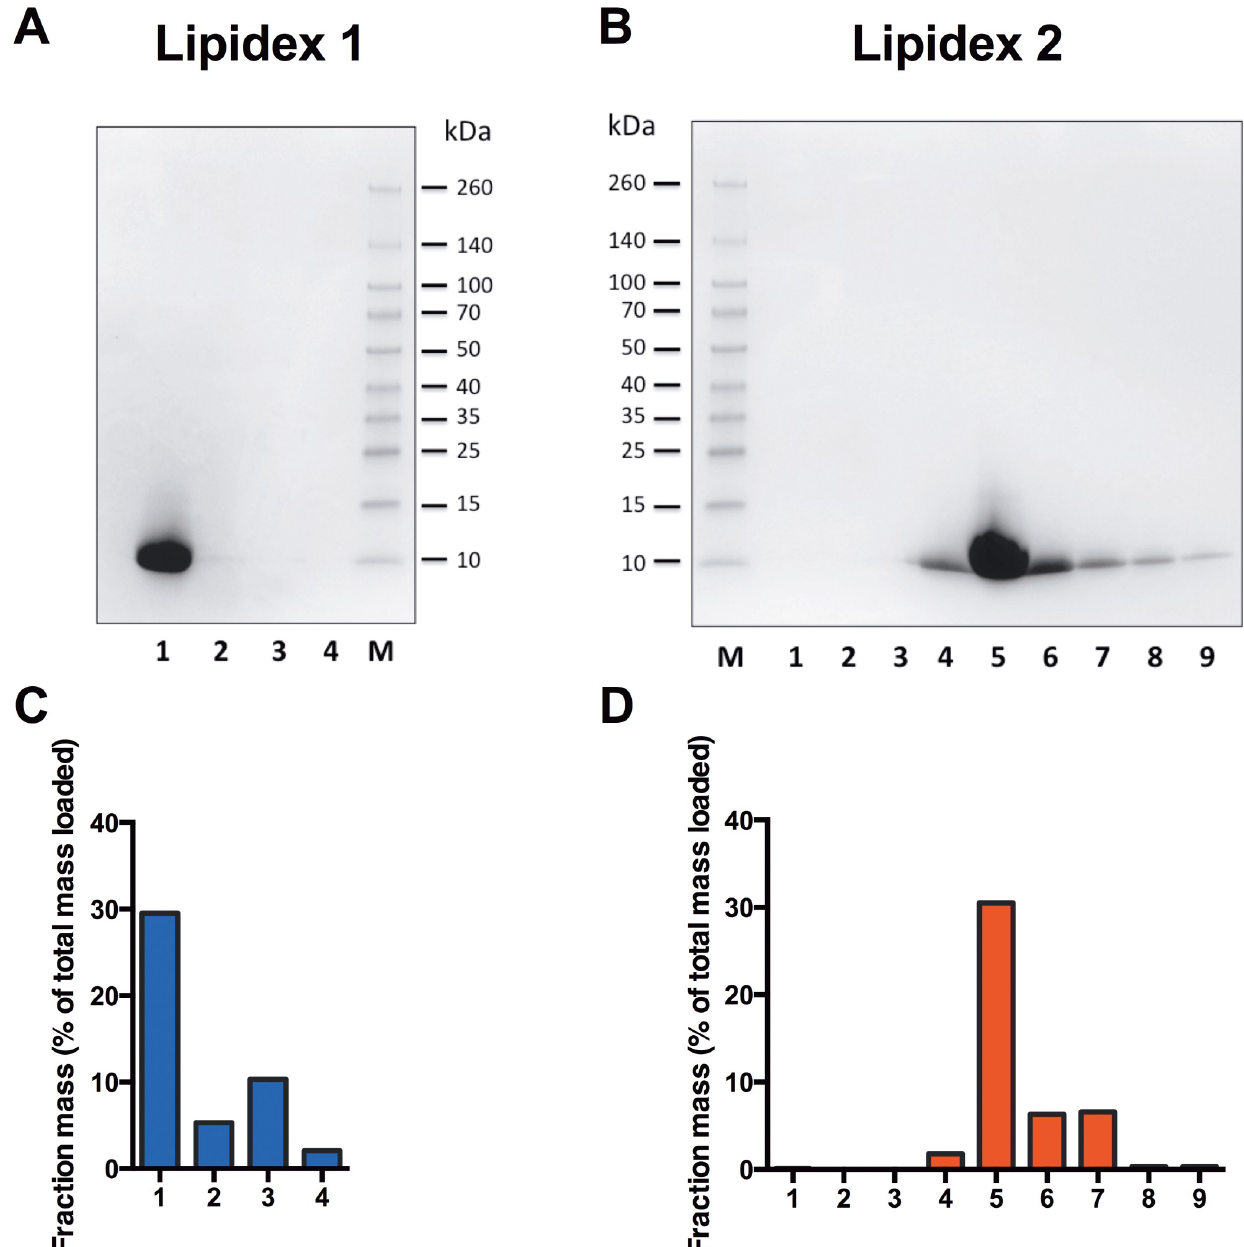
Fig 2. Liquid gel chromatography of organic extract. The organic extract containing rSP-C33Leu and obtained by salt precipitation and resolubilisation was purified by two consecutive Lipidex-5000 columns. SDS-PAGE and dry weight % of different fractions in relation to the total amount put on the column was determined for the 8 cm long first column (A and C), and the second 80 cm long column (B and D). In the first column (C), fraction 1 corresponds to a volume of 28 ml (0.7 column volume), fraction 2 to 20 ml (0.5 column volumes) and fractions 3 and 4 to 40 ml (1 column volume) each. In the second column (D), fraction 1 corresponds to a volume of 100 ml (0.25 column volumes) and the rest of the fractions to 10 ml (0.025 column volumes) each.